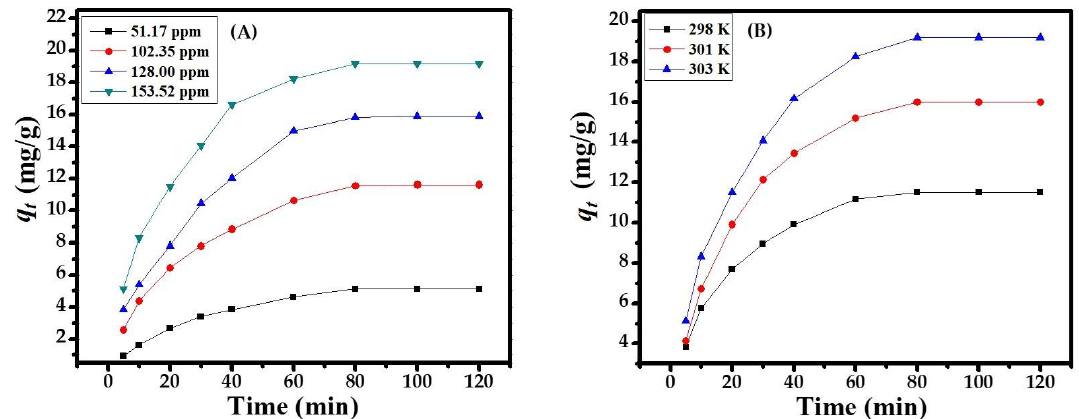
Figure 4. ( A ) Effect of dye concentration at pH 12; ( B ) Effect of dye temperature at 298, 301, and 303 K.